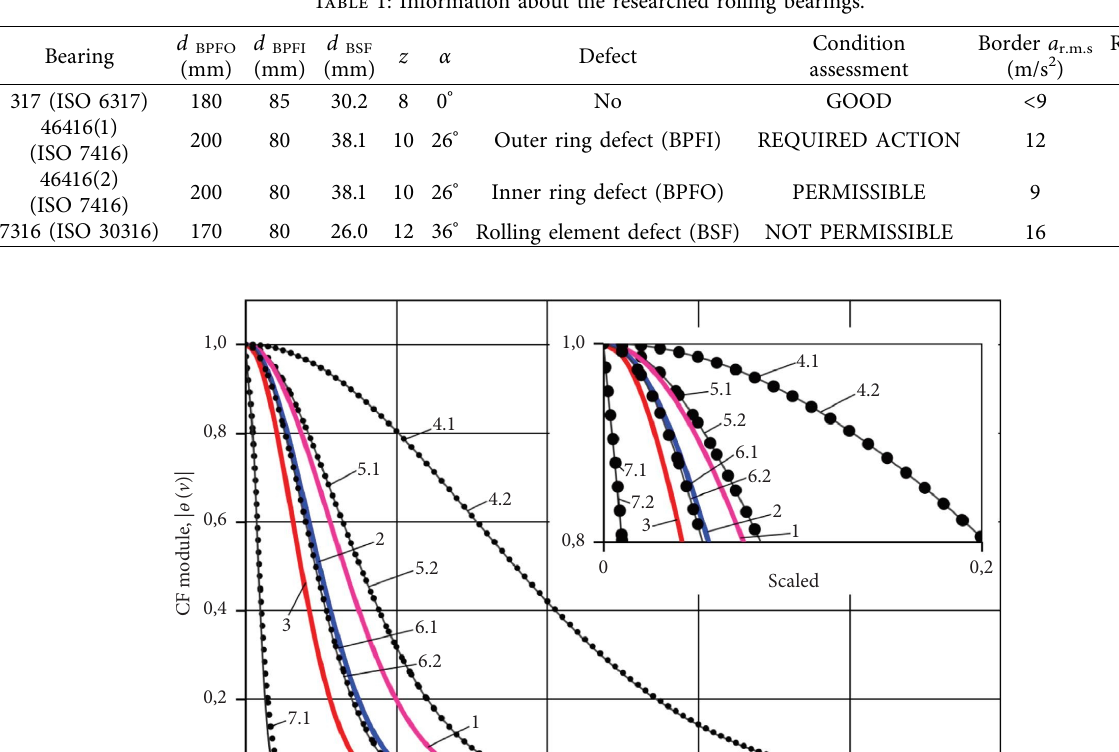
Figure 3: Rotor kit with installed bearing. Table 1: Information about the researched rolling bearings.